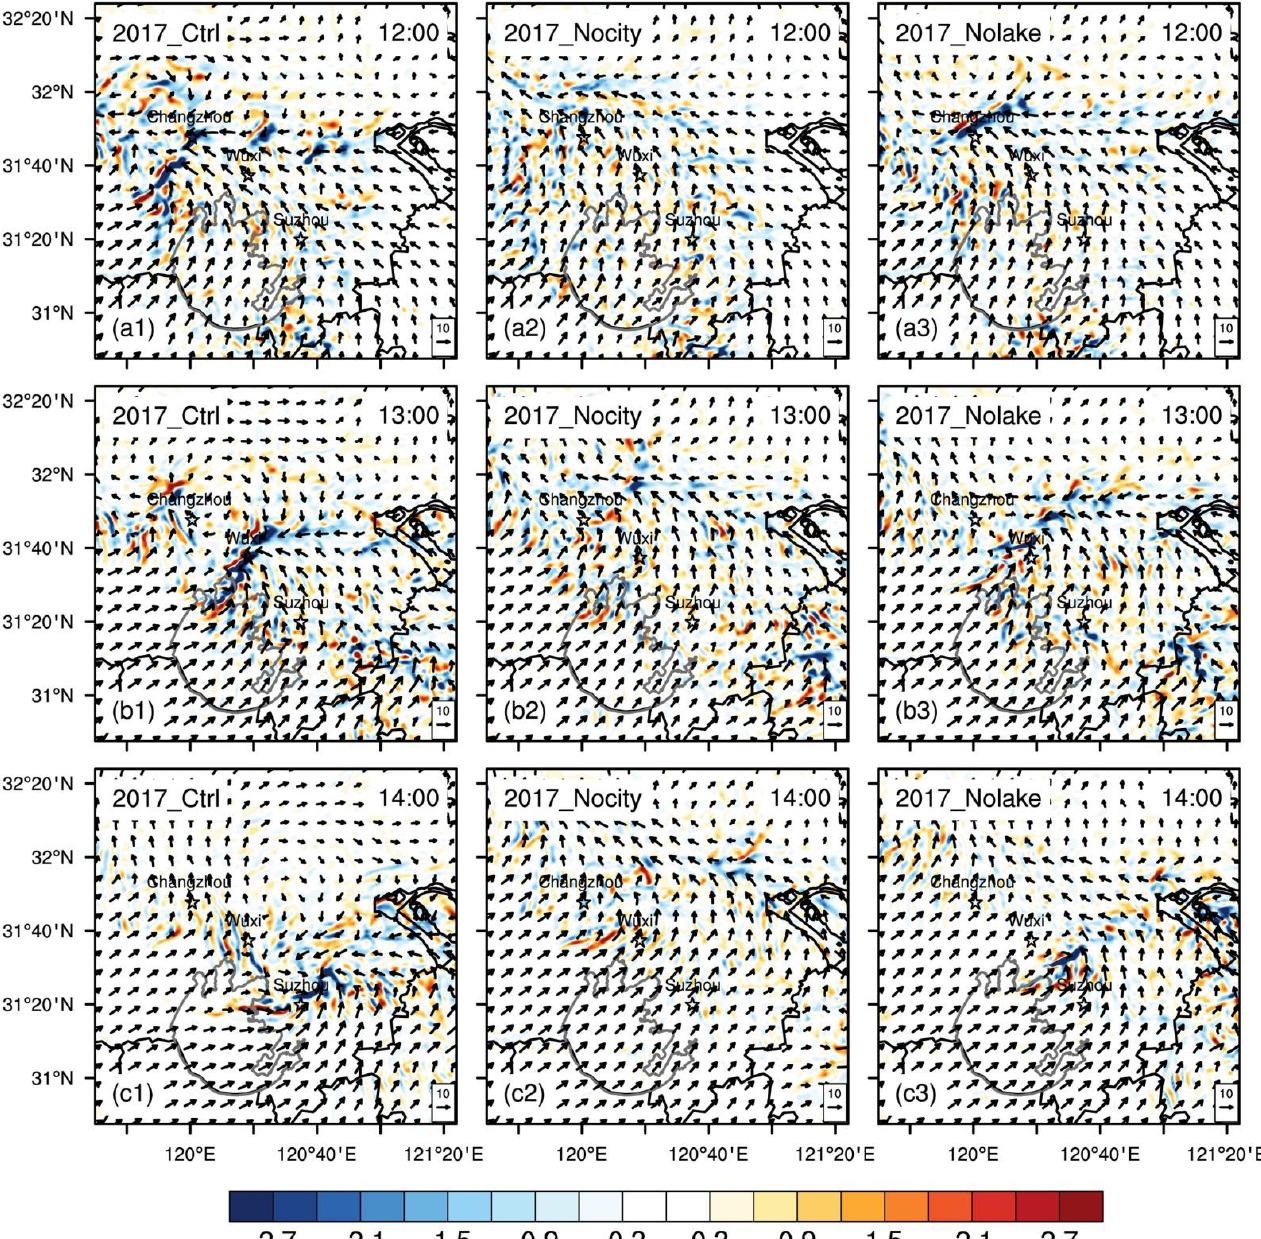
Figure 13. The spatial distributions of the 925 hPa wind direction and divergence (unit: 10 −3 s −1 ) for the ( a1 , b1 , c1 ) control, ( a2 , b2 , c2 ) Nocity, ( a3 , b3 , c3 ) Nolake runs for EP925.